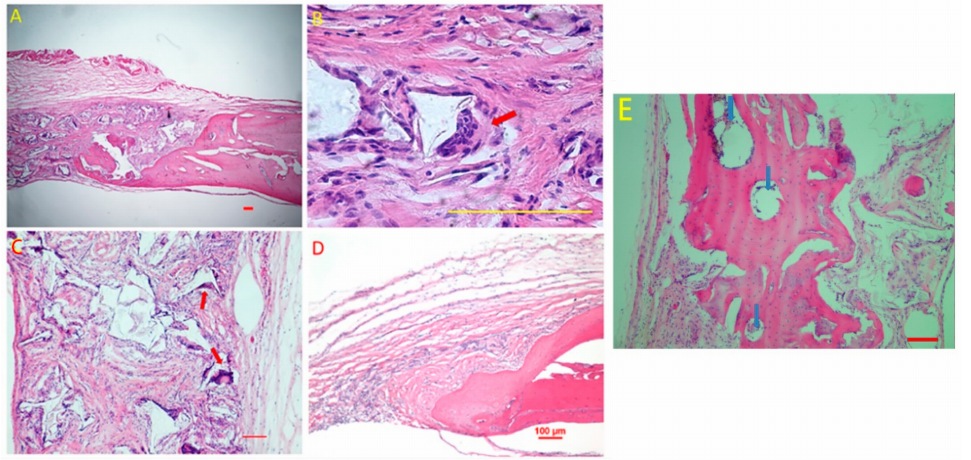
Figure 3. Hematoxylin and eosin (HE) staining results. New regenerated tissues, including osteoid and collagen, were observed in the region of defects ( A , C , D ). Multinucleated giant cells, indicated as red arrows ( B , C ), can be seen around the scaffold fragments. Sections from the empty group showed that newly formed osteoid was observed from the cutting edge, and the calvarial defects were filled with collagen ( D ). ( E ) Osteoid formed around the blood vessels in the CO group (indicated by blue arrows). Scale bar: 100 µ